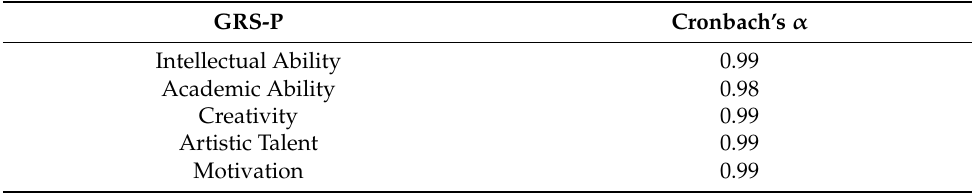
Table 4. Internal consistency reliability coefficients for GRS-P.